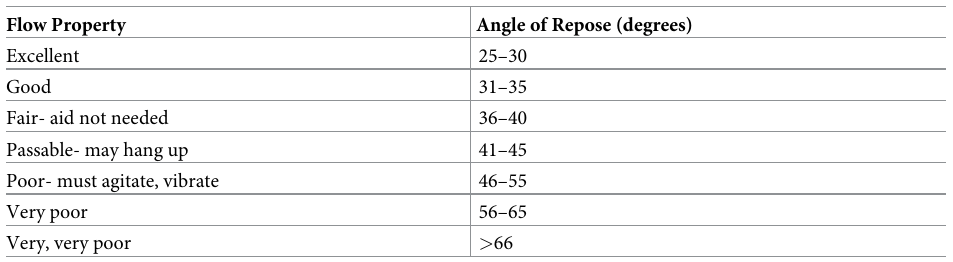
Table 2. ( < USP 1174 > ) flow properties and corresponding angles of